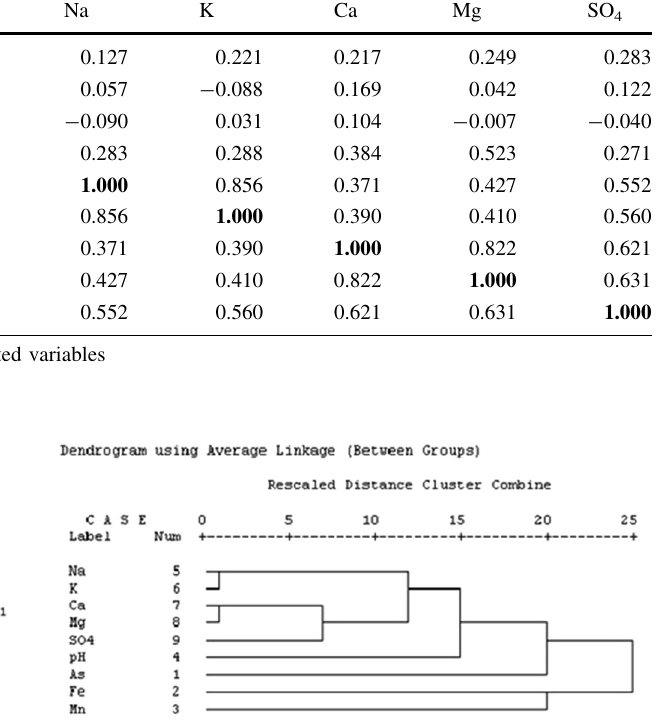
Fig. 7 Dendrogram showing the clusters of different water quality parameters in the dry season